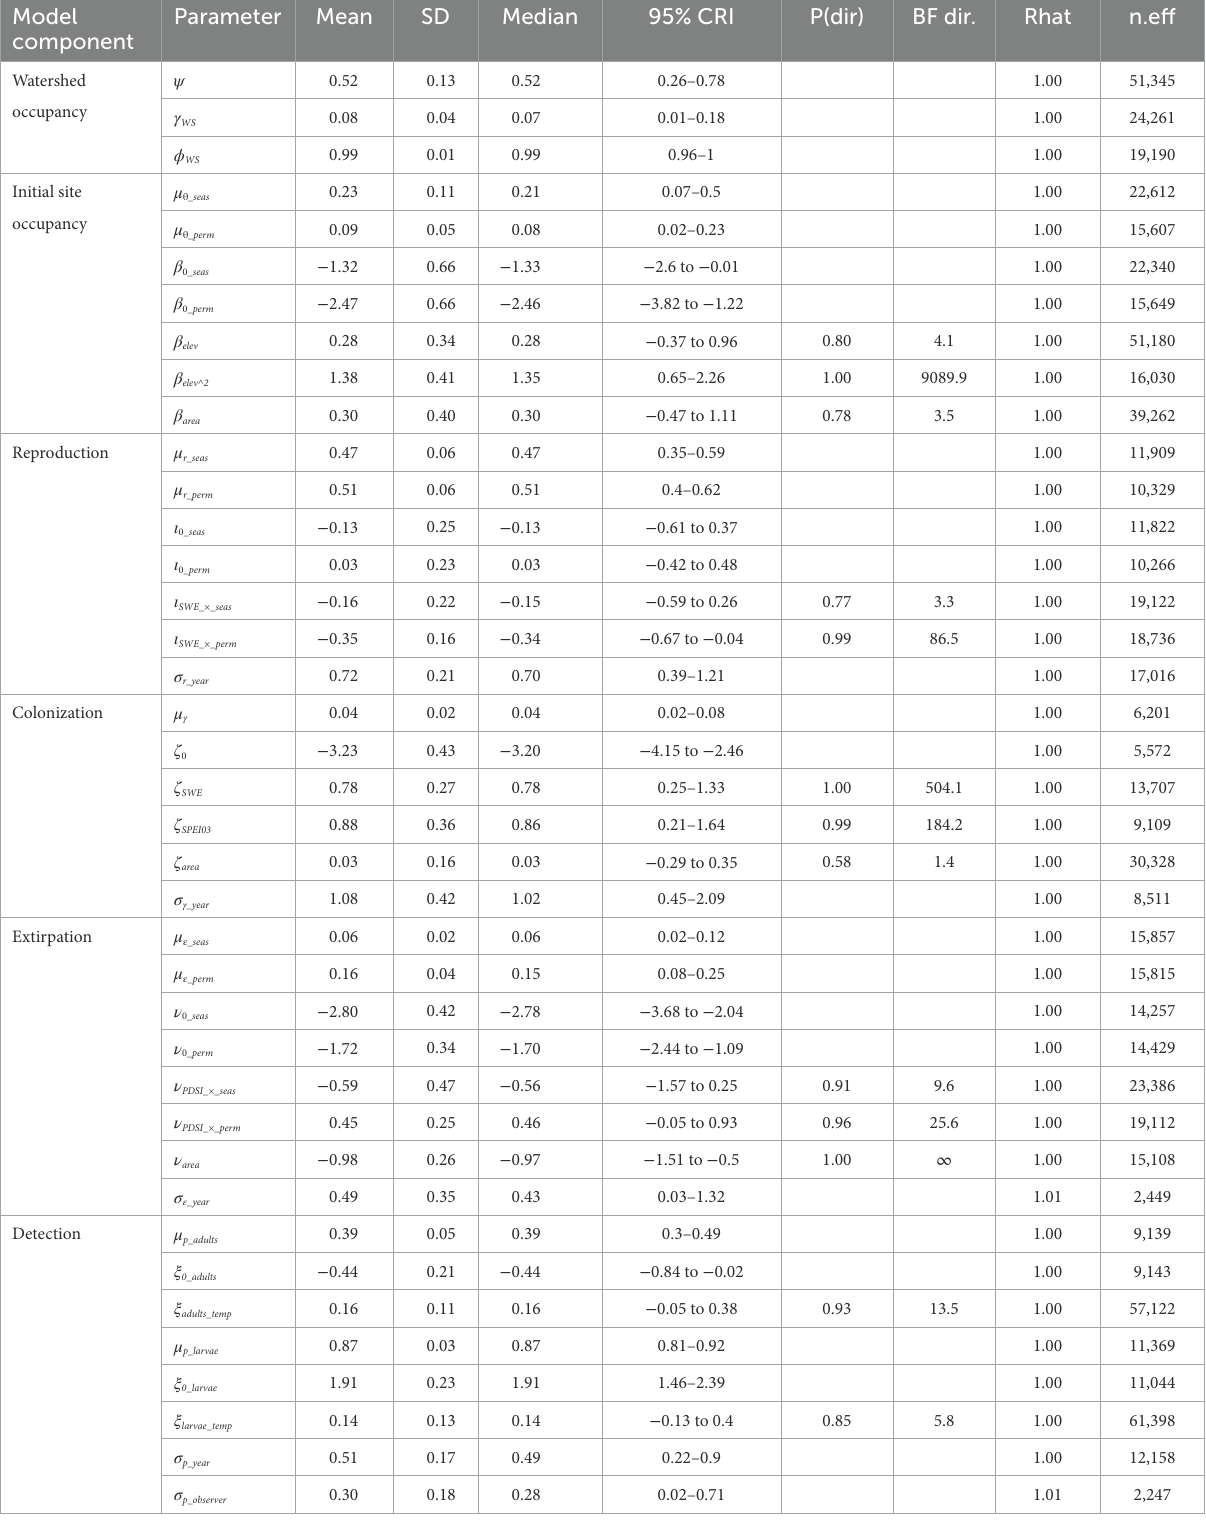
TABLE 4 Posterior summaries and Markov chain Monte Carlo (MCMC) diagnostics of parameters for the multi-state dynamic occupancy model for Yosemite toads ( Anaxyrus canorus ) in Yosemite National Park, California, United States, 2007–2021. Model Parameter Mean SD Median 95% CRI P(dir) BF dir. Rhat component